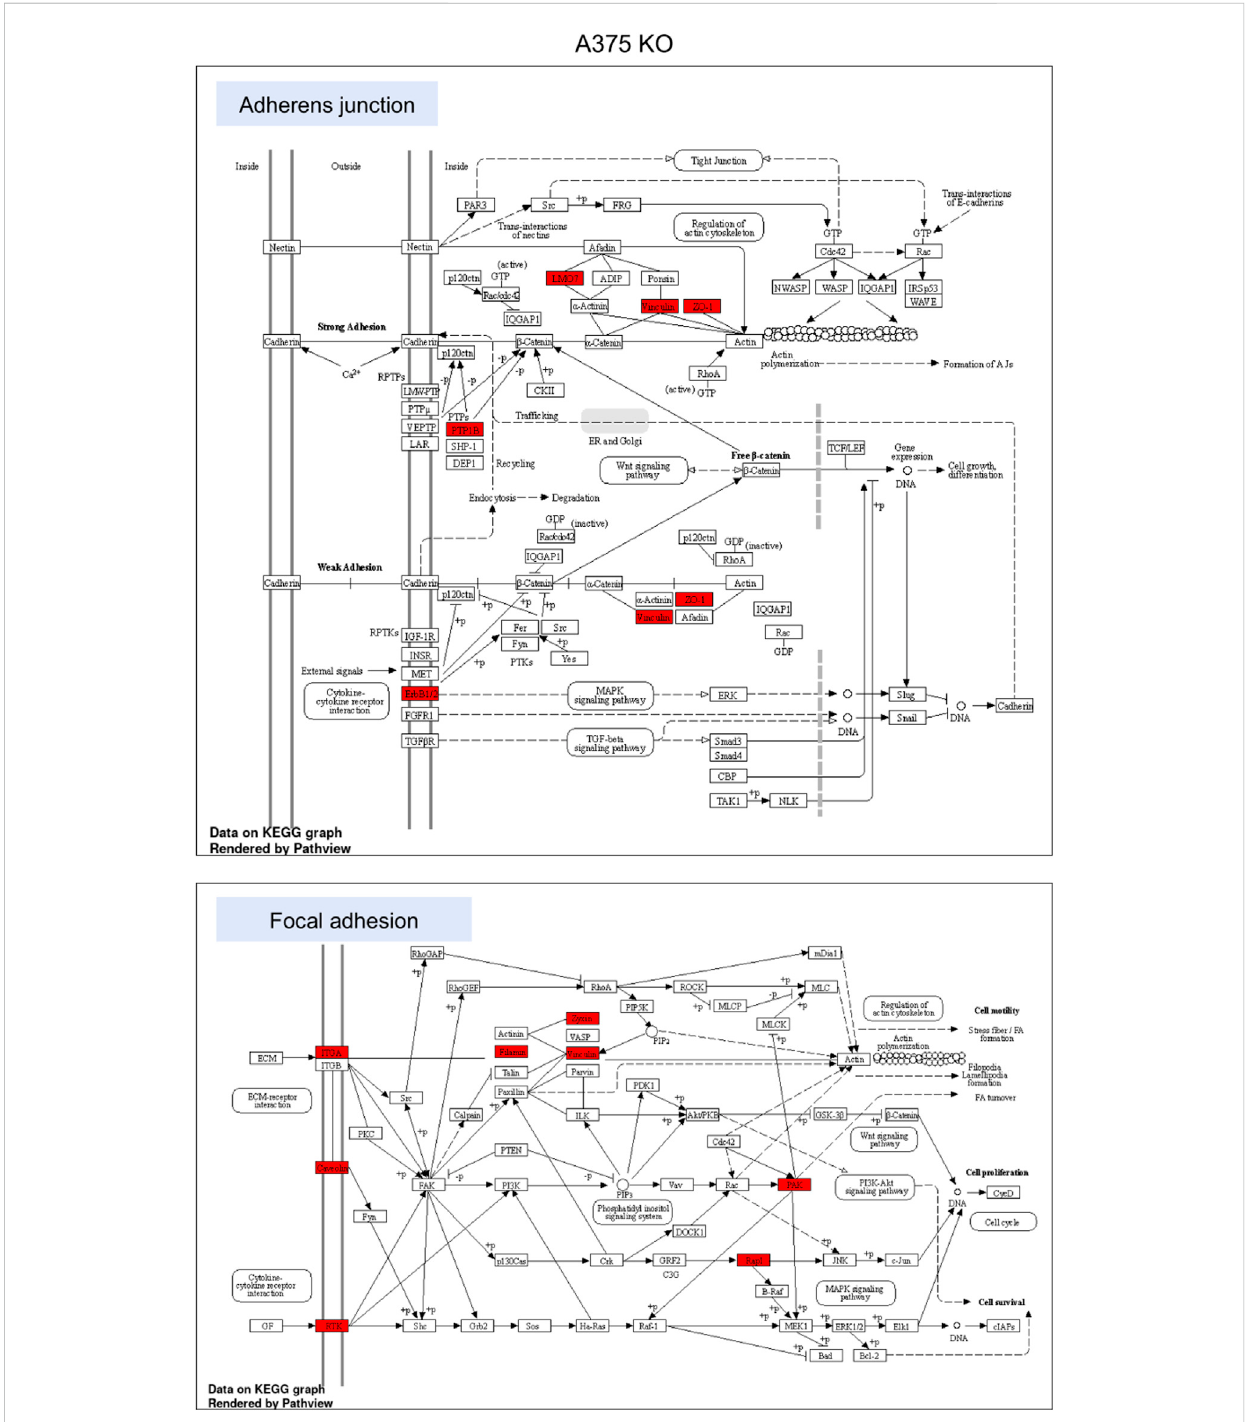
FIGURE 6 KEGGpathwayenrichmentanalysis inA375 parental cell line.Red represented high expression. Abbreviations:KEGG – Kyoto Encyclopediaof Genes and Genomes, PA — parental; KO — knock-out. Figure 6. KEGG pathway enrichment analysis in A375 YB-1 knock-out cell line. Red represented high expression. Abbreviations: KEGG – Kyoto Encyclopedia of Genes and Genomes, PA — parental; KO —